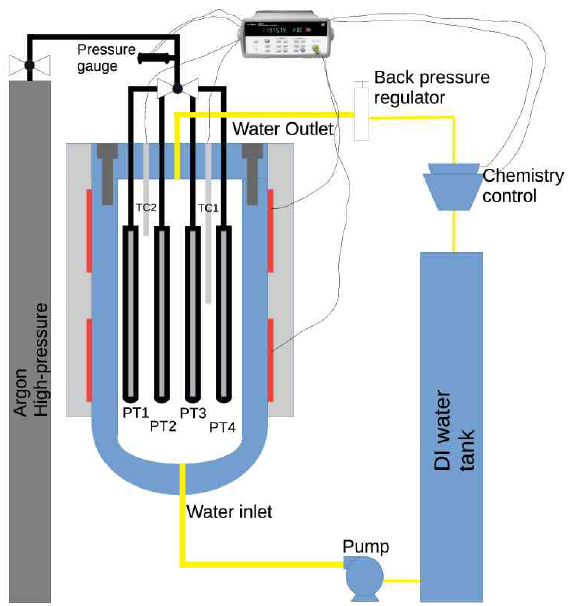
Figure 5. Schematics of the experimental setup.